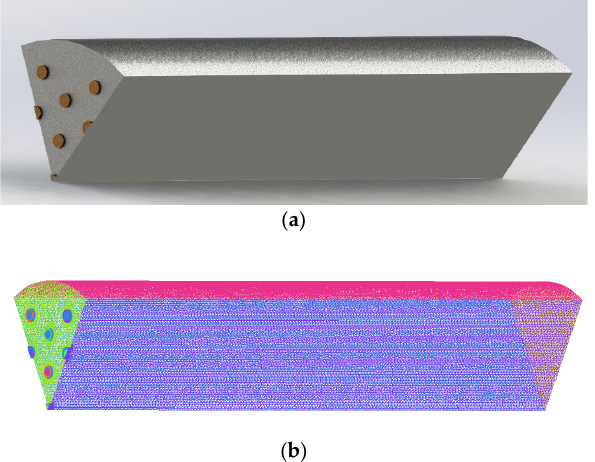
Figure 2. The 1/6 combustor structure. ( a ) Computational domain. ( b ) Computational grid.